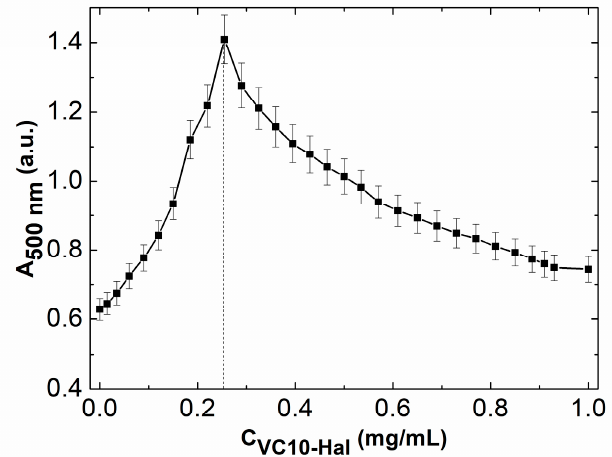
Figure 6. Turbidimetric titration of 1 mg/mL PGM with 1 mg/mL solution of VC10 – Hal (1:1).